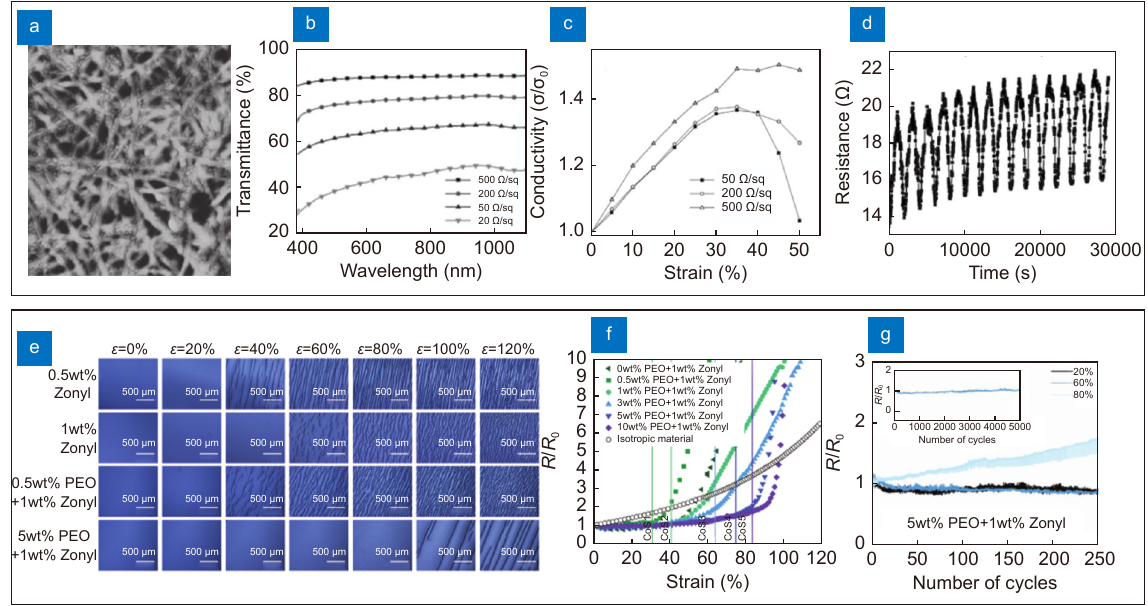
Fig. 7 | Intrinsically stretchable conductors in optoelectronic applications. ( a ) AFM image of SWCNT-based elastomeric composite elec- trode. ( b ) Optical transmittance of the electrode. Electrical performance of the electrode during ( c ) different stretching strains and ( d ) cyclic stretching test. ( e ) Changes in surface morphology of intrinsically stretchable electrodes fabricated by mixing PEDOT:PSS, PEO, and Zonyl with different ratios. ( f ) Change in resistance of the electrodes with respect to increasing the applied strain. ( g ) Stability of the optimized electrode dur- ing cyclic stretching. Figure reproduced with permission from: (a–d) ref. 168 , (e–g) ref. 170 , John Wiley and